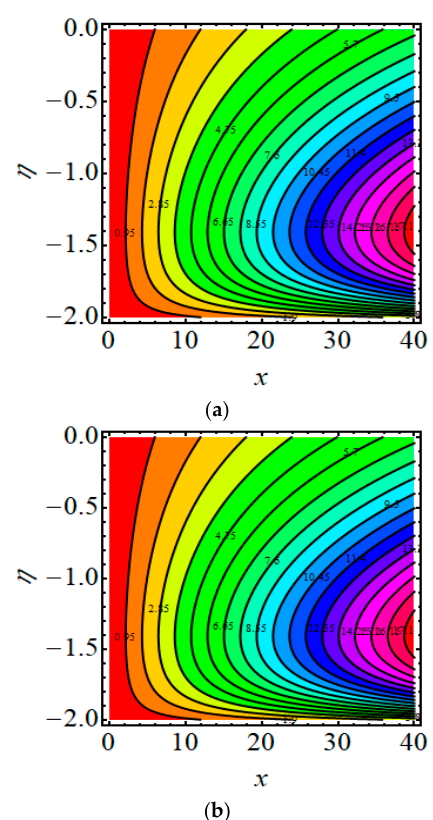
Figure 12. ( a , b ) Isotherm lines ( a ) 𝛽 (cid:3404) (cid:3398)2.5 and ( b ) 𝛽 (cid:3404) (cid:3398)2.5 .